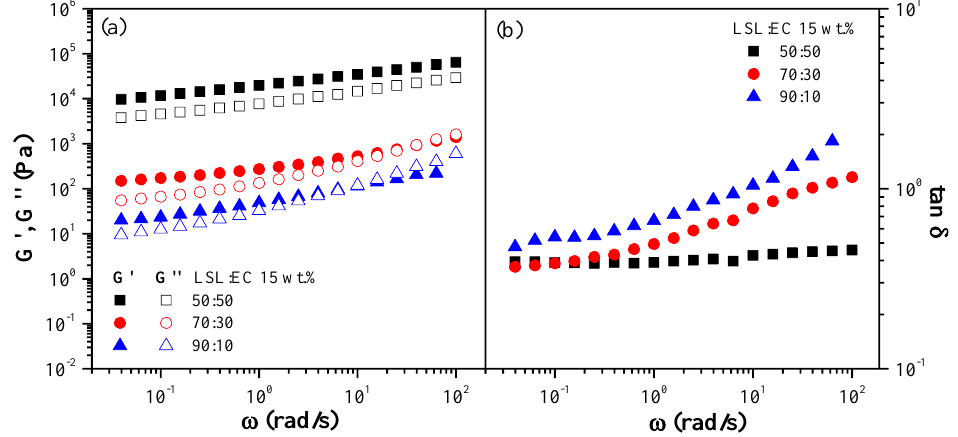
Figure 4. Frequency dependence of ( a ) the storage and loss moduli and ( b ) the loss tangent for oleo- dispersions formulated with the same nanostructure (70:30/LSL:EC ratio) at different concentrations.